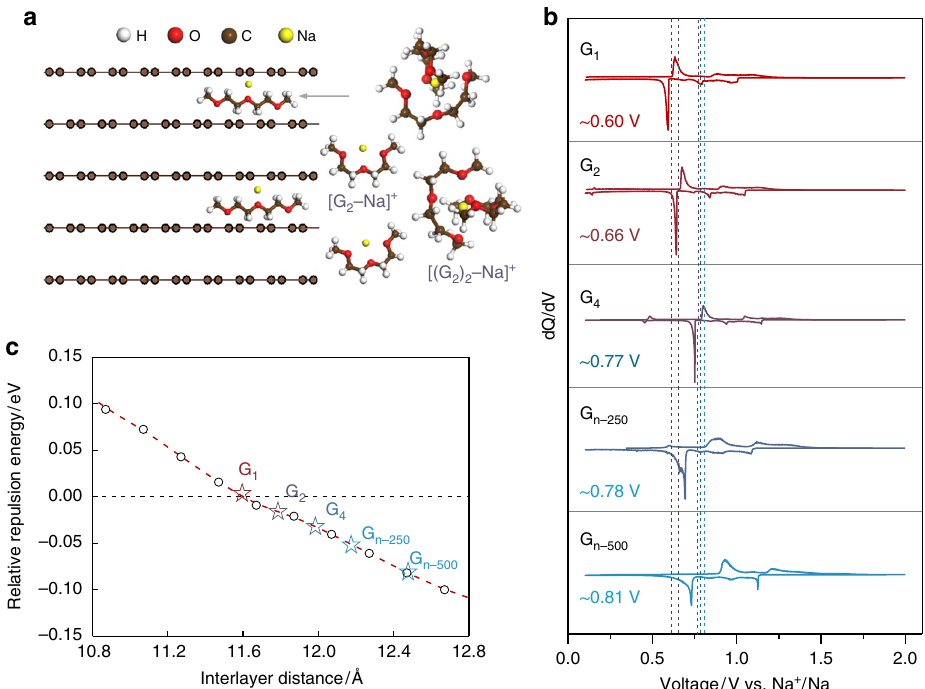
Fig. 1 Solvent dependency of co-intercalation voltage. a Schematic illustration of solvated Na ion co-intercalating into graphite galleries. b dQ/dV plots of graphite electrodes cycled in 1 M NaPF 6 G 1 , G 2 , G 4 , G n – 250 , and G n – 500 electrolytes, respectively. c Plot of normalized repulsion energy as a function of interlayer distance to elucidate the correlation between Na storage potential in graphite and ethers used in